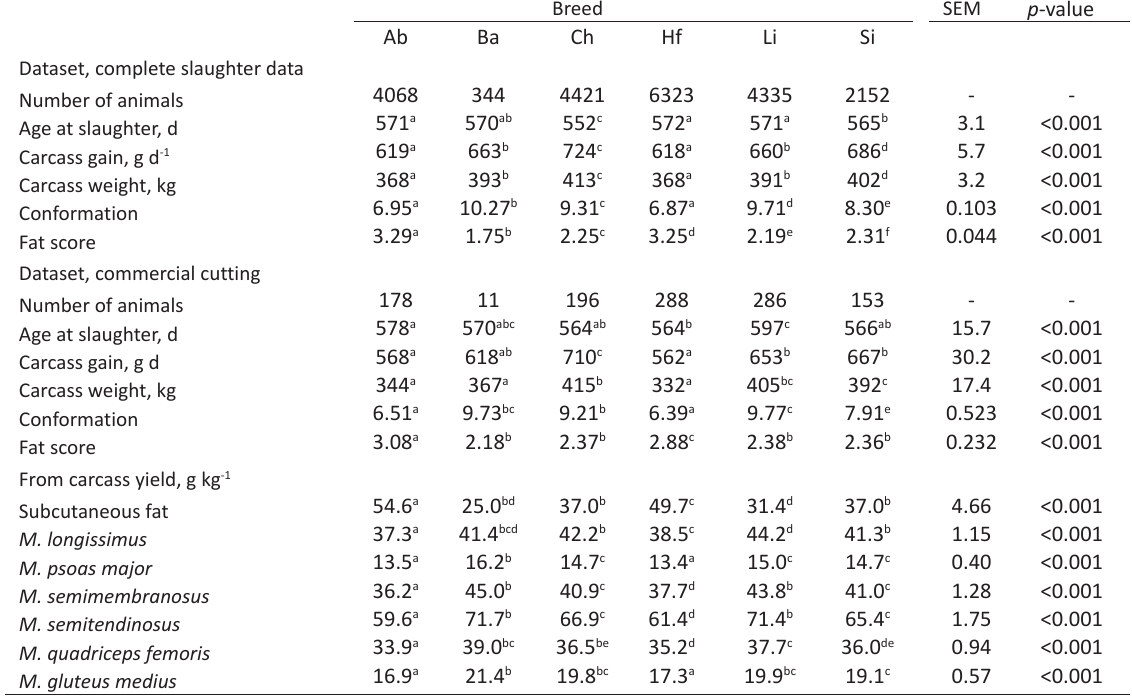
Table 2. Carcass gain, carcass characteristics and valuable cuts of Aberdeen Angus (Ab), Blonde d’Aquitaine (Ba), Charolais (Ch), Hereford (Hf), Limousin (Li) and Simmental (Si) bulls in Finnish slaughter dataset. Between-breeds comparisons (Tukey, p <0.05): estimated means with the different letters were significantly different ( p